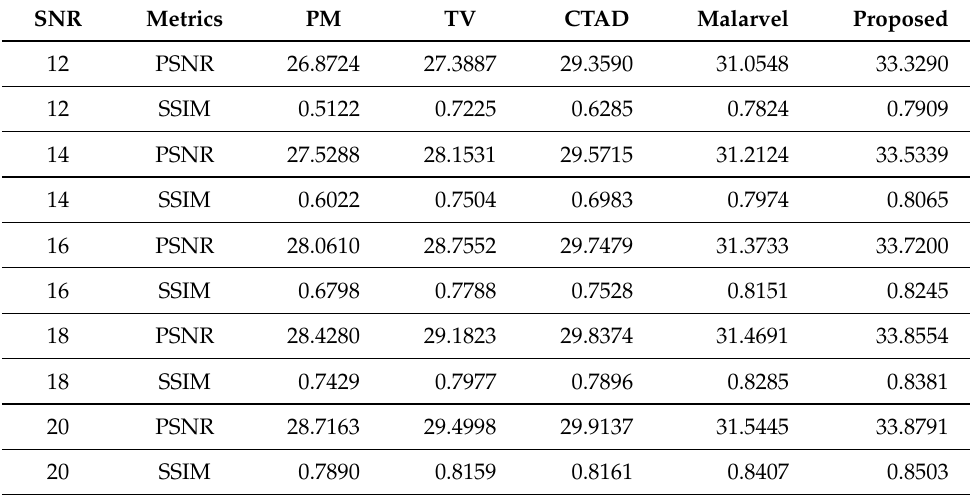
Table 4. House image experiment results evaluation.